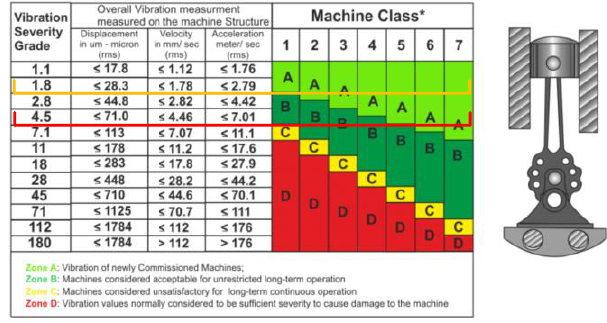
Fig. 17. Range of mechanical vibration values for internal combustion engines depending on engine class – ISO 10816-6